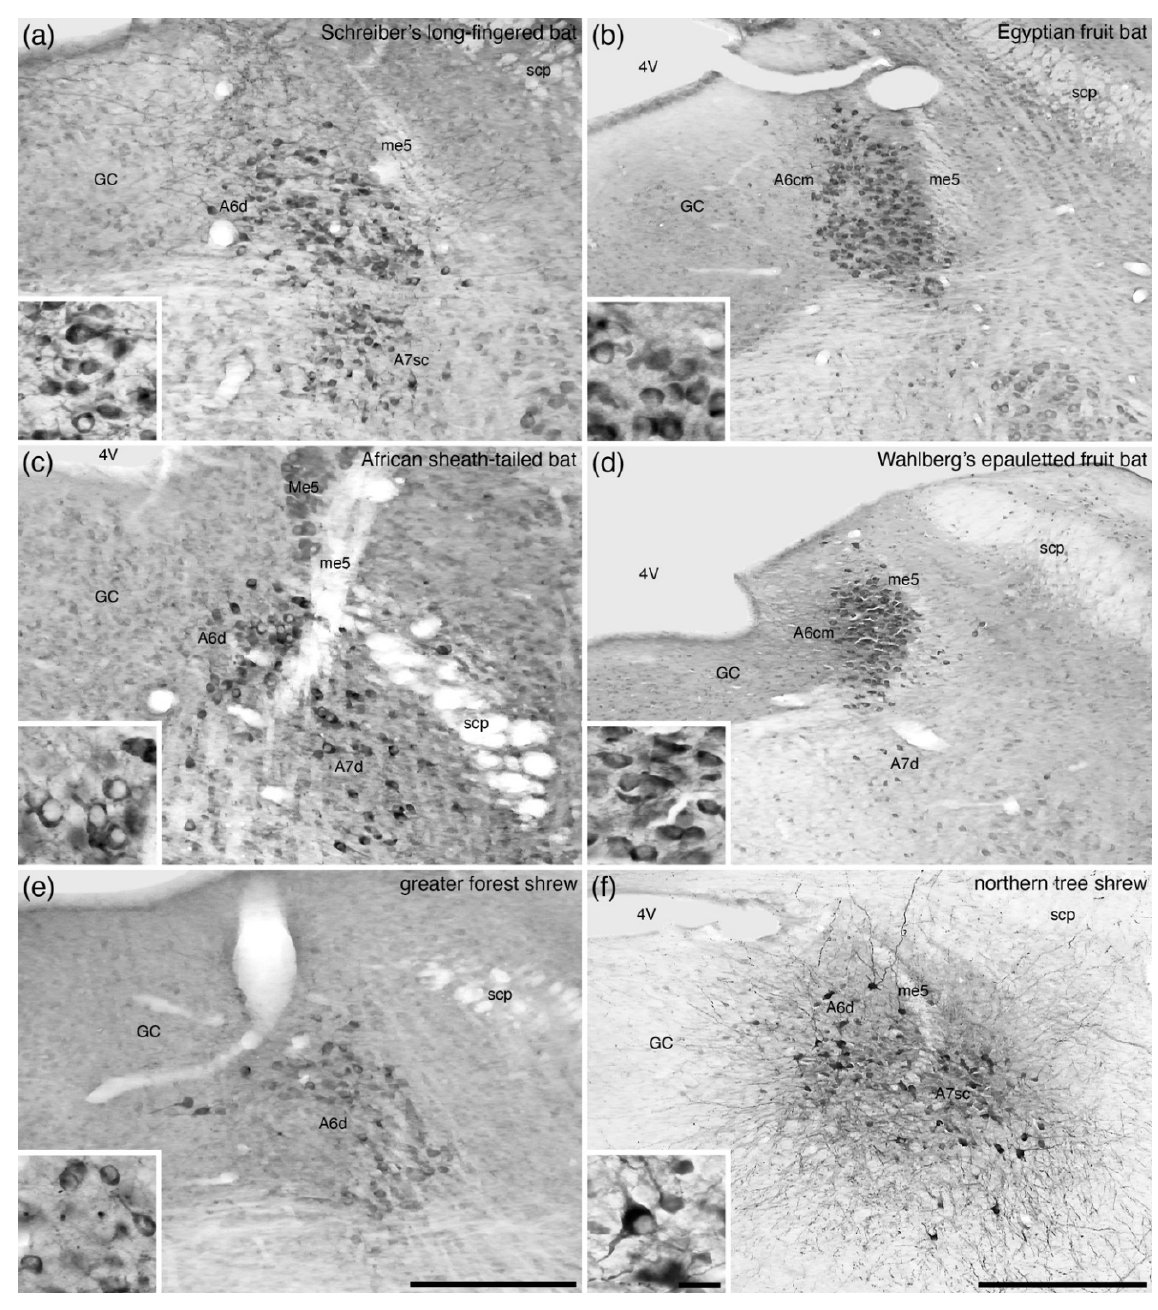
Figure 8. Low-magnification photomicrographs of the locus coeruleus ( A6 ), revealed with tyrosine hydroxylase immunostaining, in the brains of two species of microchiropteran bats, ( a ) Schreiber’s long-fingered bat ( Miniopterus schreibersii ) [21] and ( c ) the African sheath-tailed bat ( Coleura afra ) [22], two species of megachiropteran bat, ( b ) the Egyptian rousette ( Rousettus aegyptiacus ) [23] and ( d ) Wahlberg’s epauletted fruit bat ( Epomophorus wahlbergi ) [24], ( e ) the greater forest shrew ( Sylvisorex ollula ) [19], and ( f ) the northern tree shrew ( Tupaia belangeri ) [50]. Note how the density of neurons in the locus coeruleus of the microchiropterans ( a , c ), the greater forest shrew ( e ), and the northern tree shrew ( f ) show the diffuse-type of organization ( A6d ) typical of mammals. In contrast, the locus coeruleus in the two species of megachiropterans ( b , d ) show a very high density of cells ( A6cm , compact portion of the locus coeruleus, megachiropteran-type), as well as peripheral regions of low density. This appearance is very similar to what is observed in primates (see Figure 7). In all images, dorsal is to the top and medial to the left. Scale bar in ( e ) = 250 µm and applies to ( a , c , e ). Scale bar in ( f ) = 500 µm and applies to ( b , d , f ). Scale bar in inset ( f ) = 25 µm and applies to all insets. 4V —fourth ventricle; A7d —locus subcoeruleus, diffuse portion; A7sc —locus subcoeruleus, compact portion; GC —periventricular grey matter of the rostral hindbrain; Me5 —fifth mesencephalic nucleus; me5 –fifth mesencephalic tract; scp —superior cerebellar peduncle.